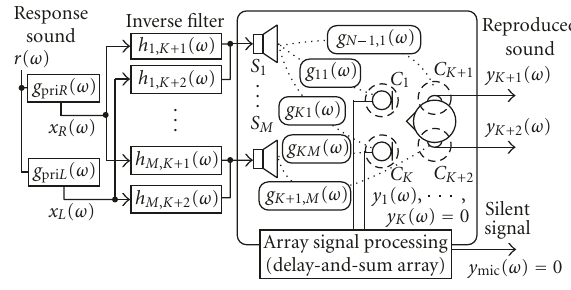
Figure 2: Configuration of the proposed